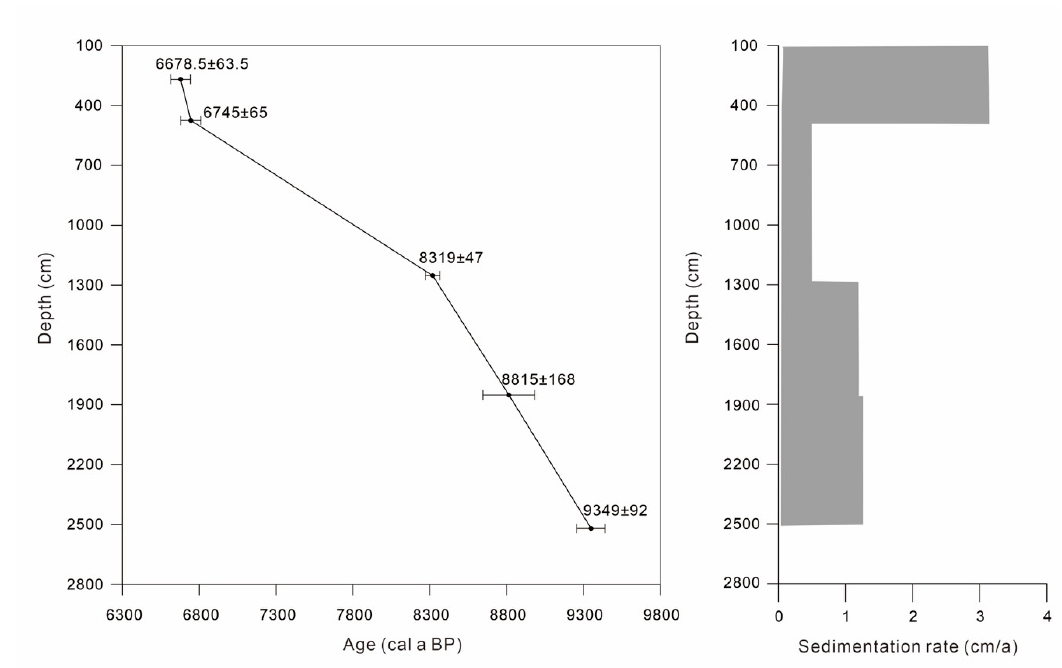
Figure 2. Age model and sedimentation rate based on AMS 14 C age determinations of core XH-2 [35].